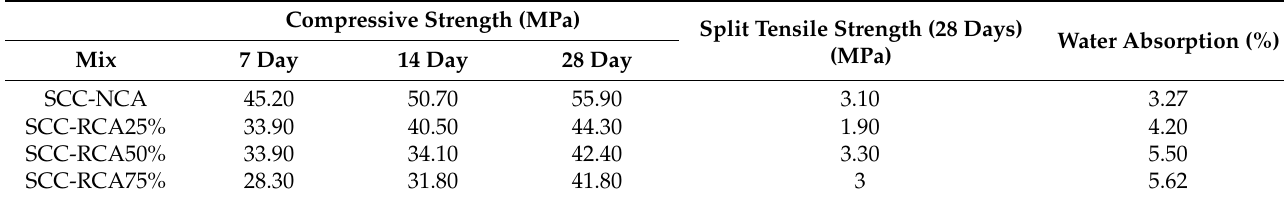
Table 3. Compressive strength and water absorption results.